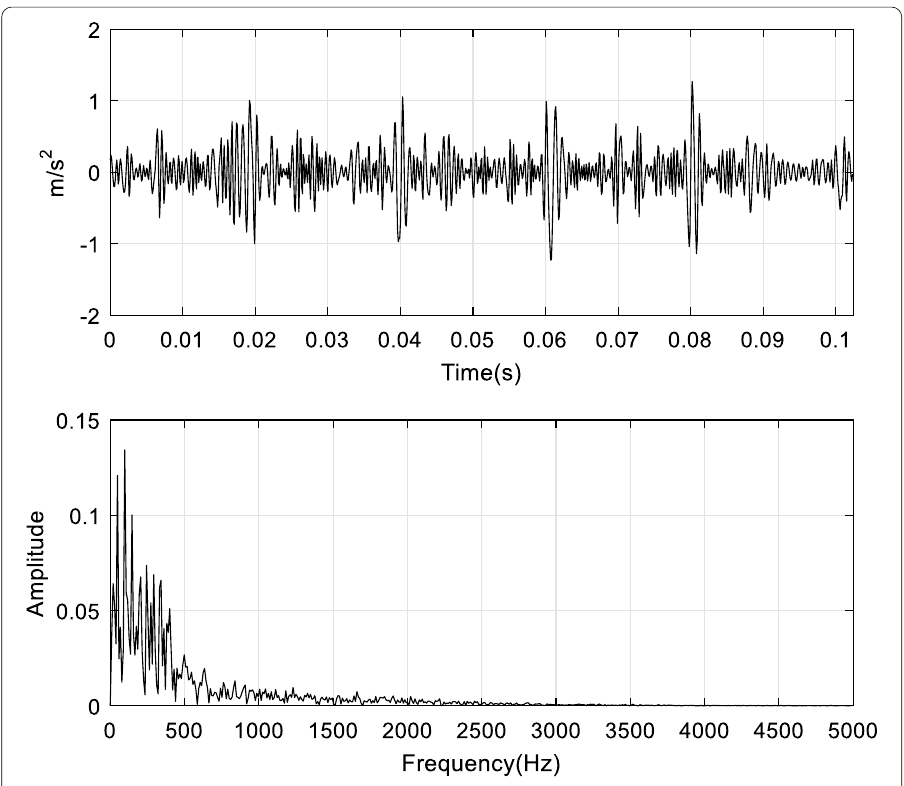
Fig. 9 Waveform and envelope spectrum of characteristic sub-band signal extracted by EEMD